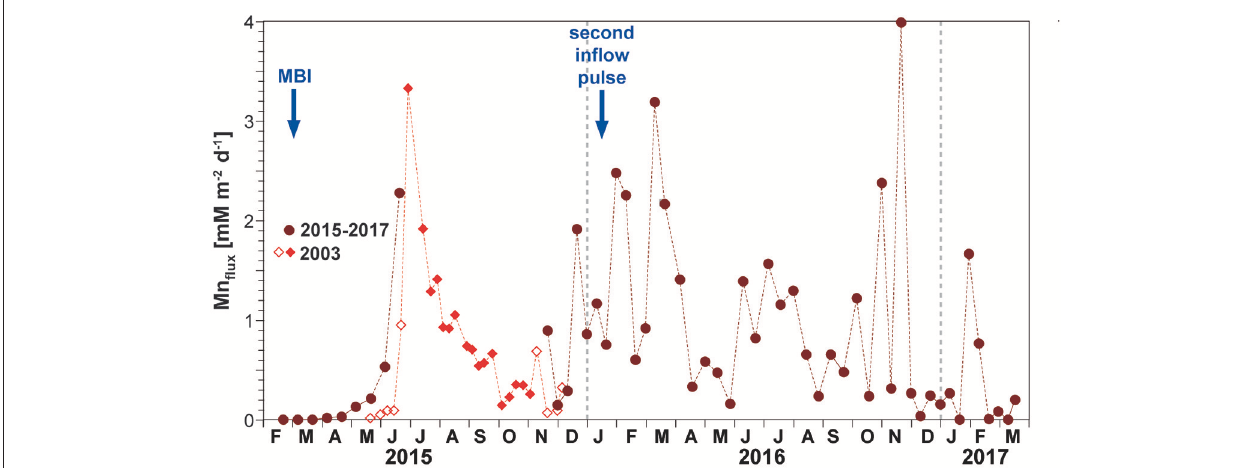
FIGURE 4 | Temporal variability of particulate Mn fluxes in a sediment trap positioned at a water depth of 186m close to station 271 in the central Gotland Basin (brown dots: 2015–2017; open and closed red squares: 2003). Closed symbols were used for budget